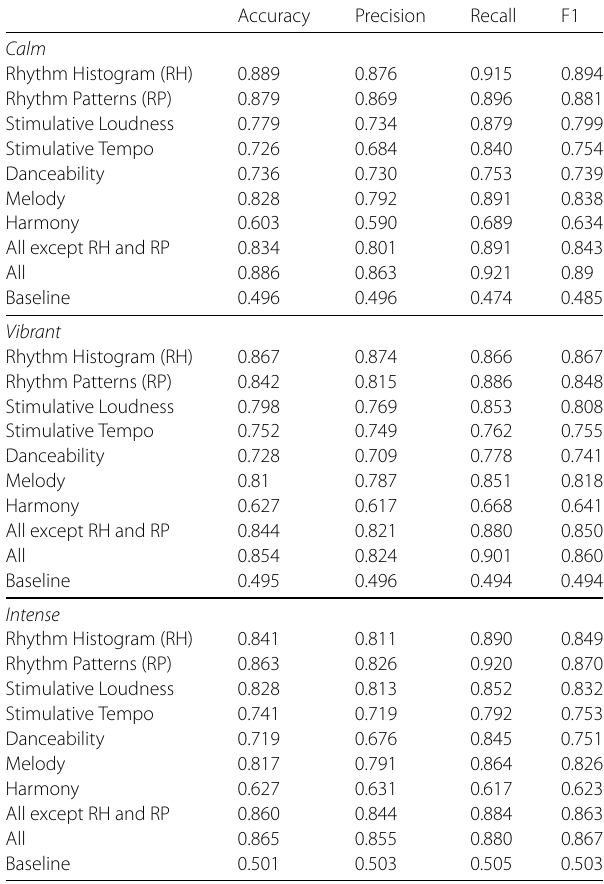
Table 3 Results of classification for three groups, in a binary ‘one vs. rest’ classification setup Accuracy Precision Recall F1 Calm Rhythm Histogram